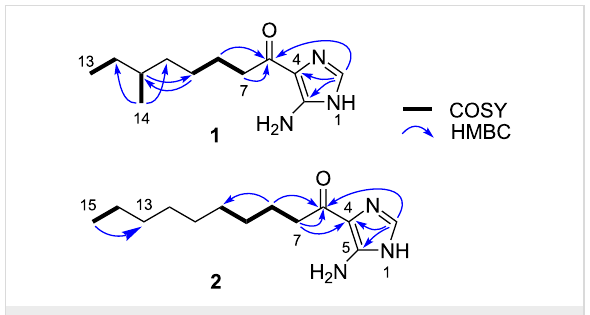
Figure 2: COSY and key HMBC correlations for 1 and 2 .